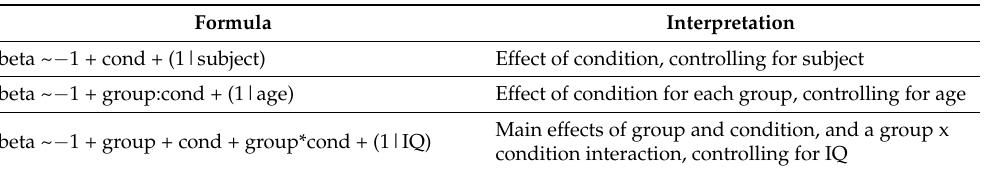
Table 3. Examples of Wilkinson–Rogers notation.